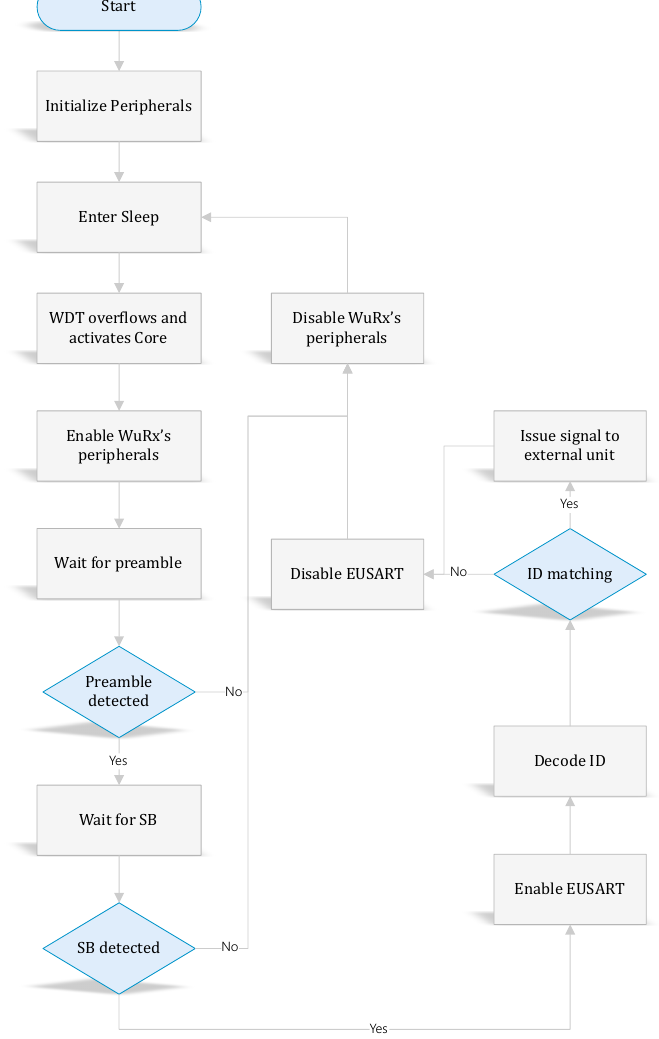
Figure 13. Decoder processing flowchart. SB, separation